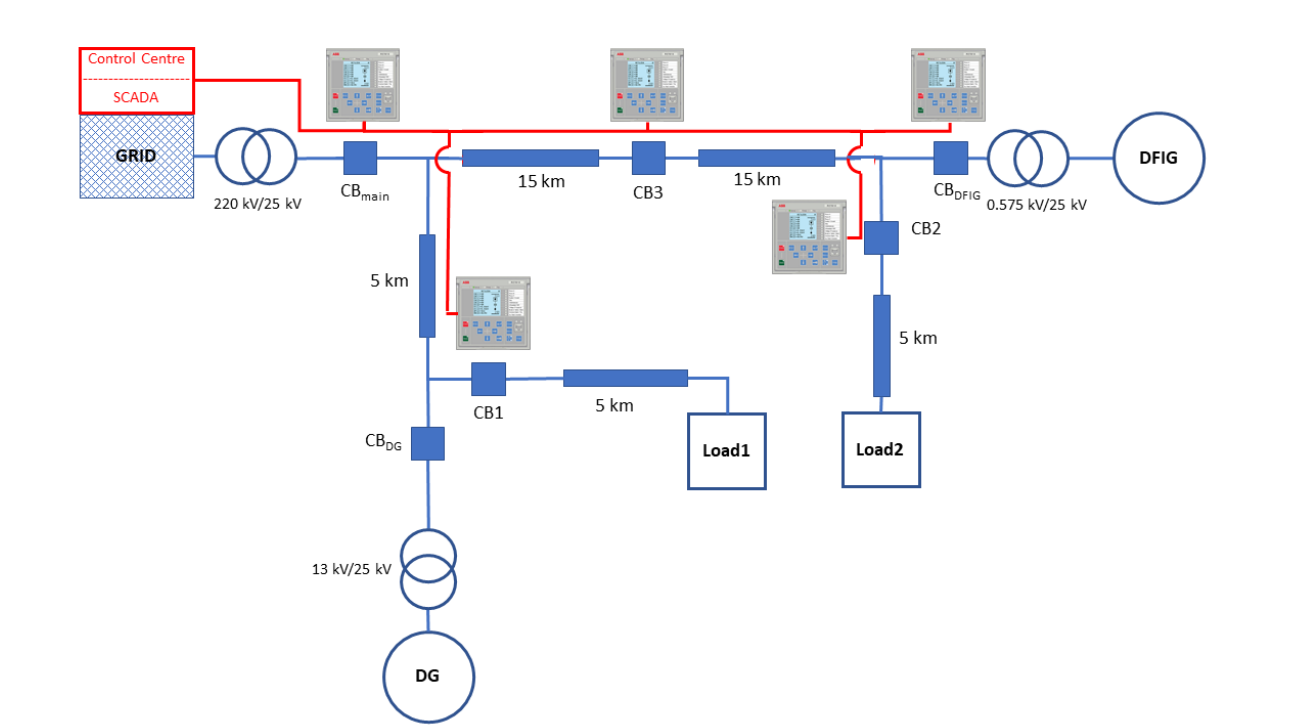
Figure 2. Architecture of the proposed test